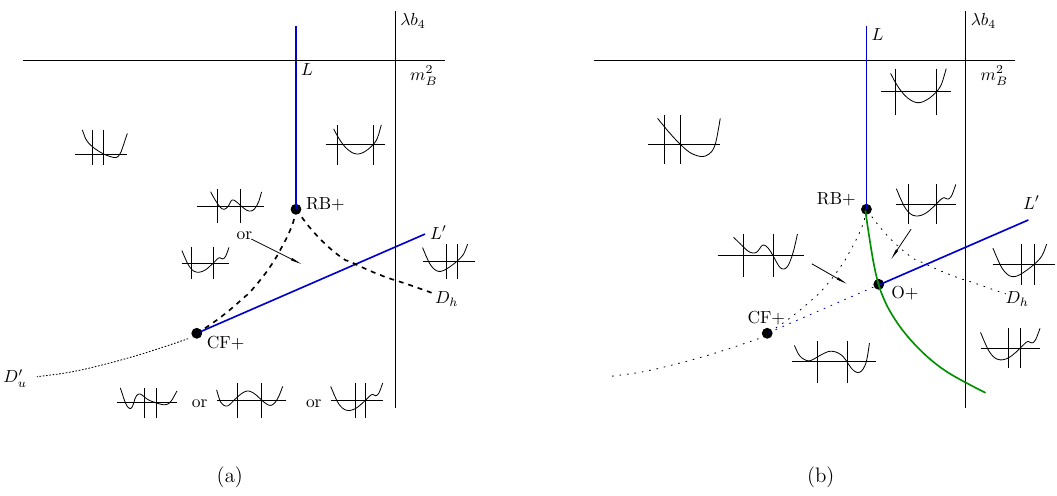
Figure 8. Deducing the phase structure for the m F = j (cid:22) j sgn( (cid:21) ) section for j (cid:21) j < 1 are the pro(cid:12)les of the potential (4.11). The two vertical lines in each plot correspond to (cid:27) = (cid:0) m F = 2 (cid:21) and (cid:27) = 0 and demarcate the regions of validity of the ( (cid:0) ; +), (+ ; +) and (+ ; (cid:0) ) branches of the potential (4.11) (cf. (cid:12)gure 6). The green line in (cid:12)gure (b) corresponds to a numerically-determined (cid:12)rst order transition line. It meets the second order transition line L 0 emanating from the point CF+ at the point